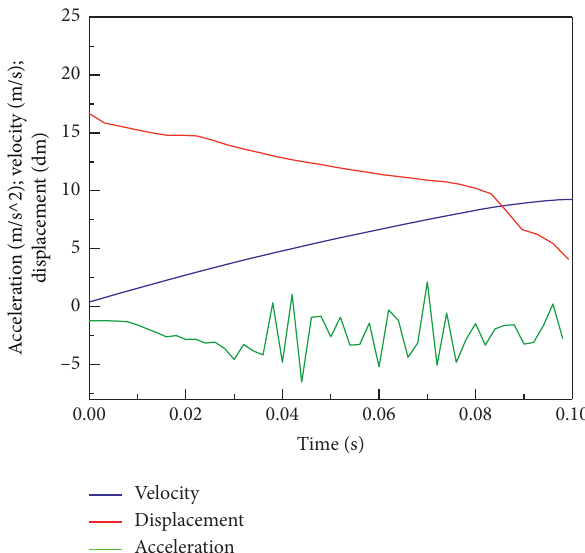
Figure 18: Results of the CLGAN model simulation.